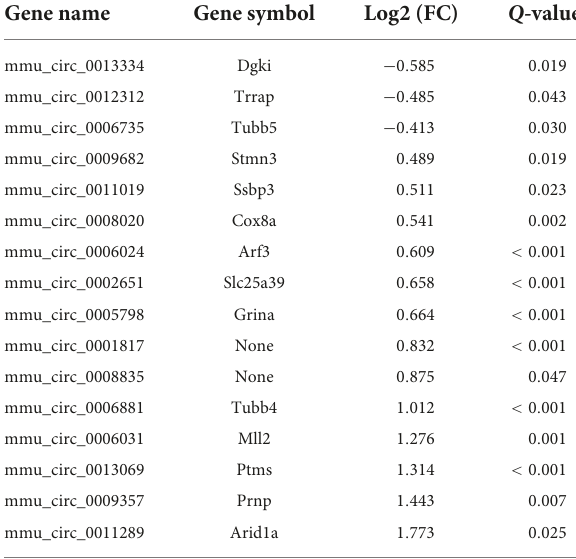
TABLE 4 Shared differentially expressed miRNAs among neuropathic pain models.